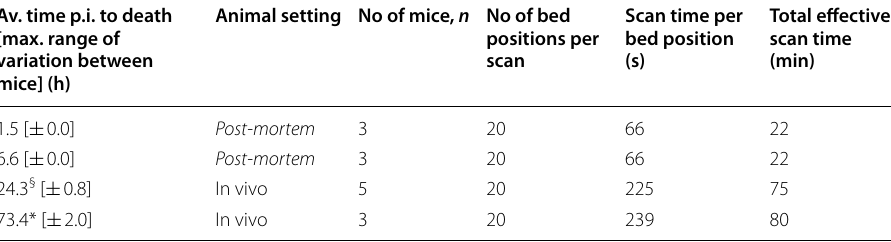
§ 23.6 h average time p.i. to middle of